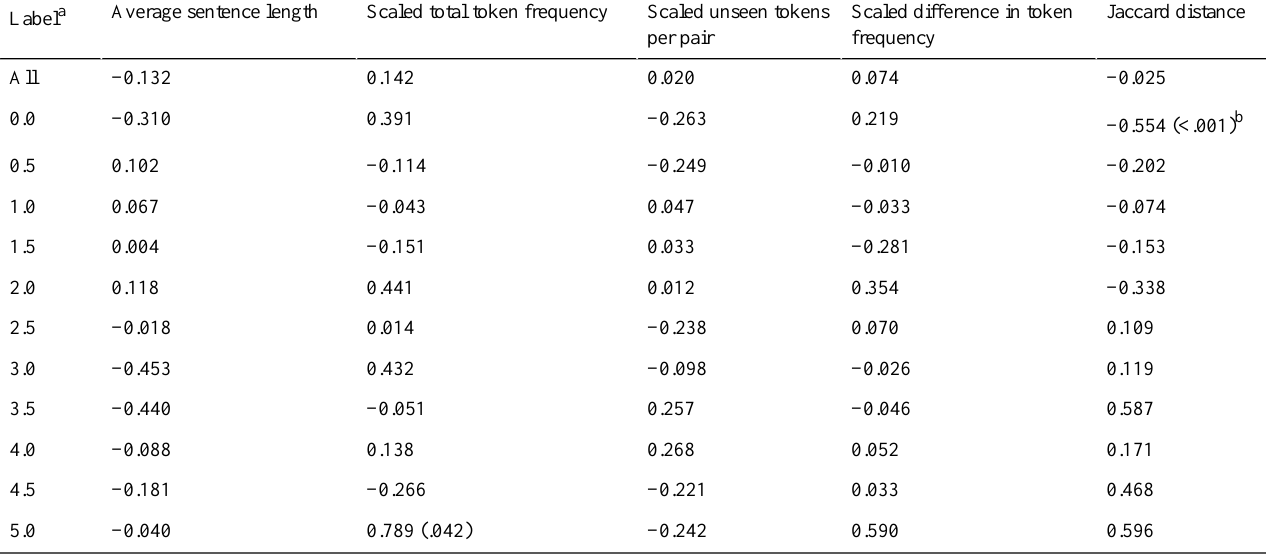
pairScaled total token frequencyAverage sentence lengthLabel a per